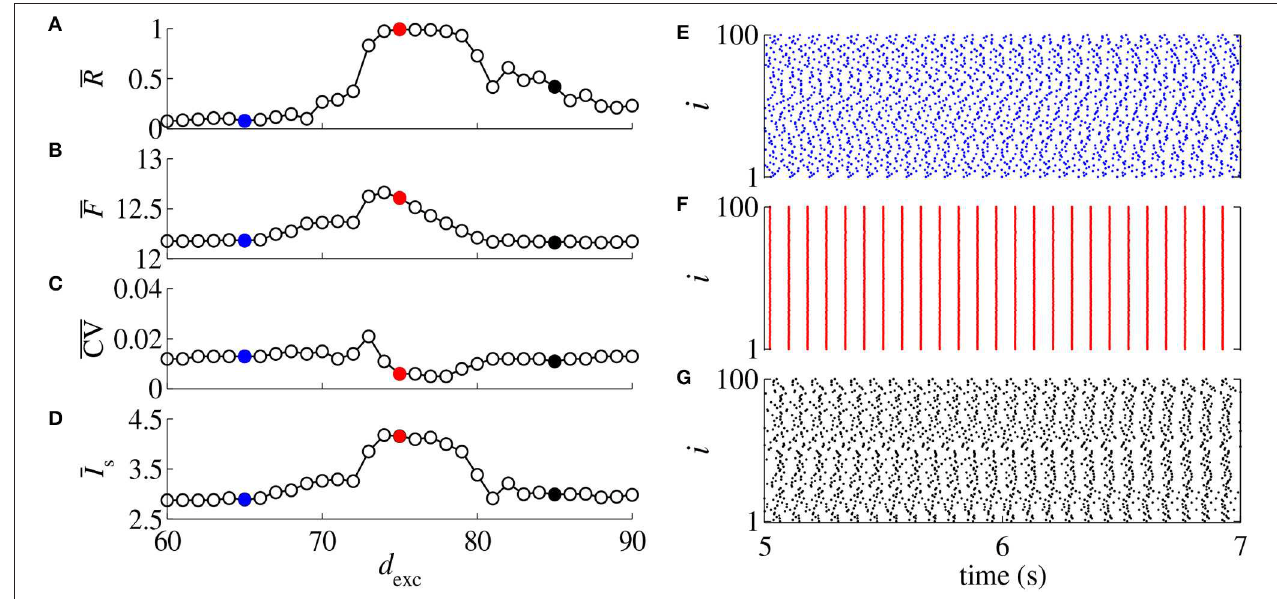
FIGURE 1 | (A) Mean order parameter ( R ), (B) mean firing frequency ( F ), (C) mean coefficient of variation (CV), and (D) mean synaptic input ( I s ) as a function of the excitatory delayed conduction d exc . Raster plots for d exc = 65 ms (E) , d exc = 75 ms (F) , and d exc = 85 ms (G) for g exc = 0.2 nS, g = 6, and d inh = 5 ms, and according to the colored circles.